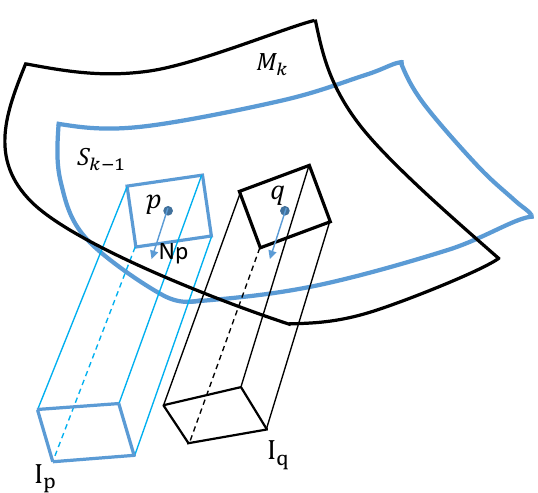
Figure 5. Illustration of the virtual plane to define color matches. p is a vertice on mesh S k − 1 with its normal n p . q is the nearest vertice to p on mesh M k . The neighboring verices around p and q are projected under the direction of n p to get the rendered image I p and I q , respectively. The neighboring might not form a rectangular, and we just use a rectangle box for simplification of